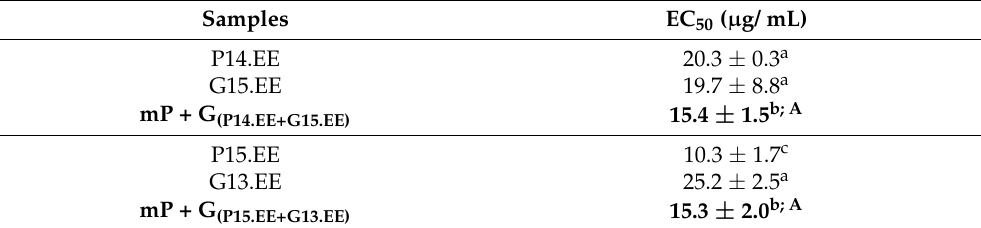
Table 6. The ability to capture DPPH • free radicals of the P.EE and G.EE mixtures is expressed as a mean ± standard deviation of EC 50 values ( µ g/ mL). Significant differences between single EEs (P and G) and mixtures (mP + G) ( p < 0.05) are noted with different lowercase letters. Significant differences between mP + G ( p < 0.05) are represented with different uppercase